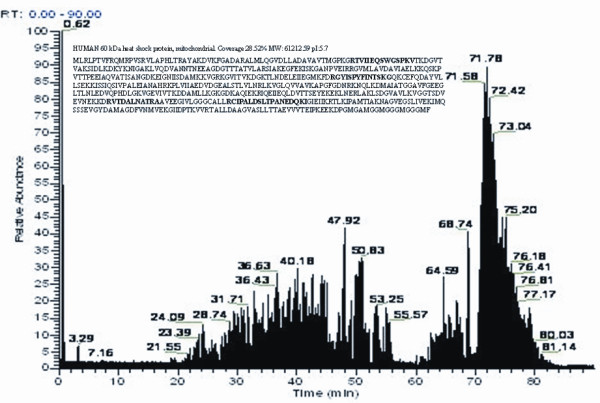
LC-MS spectrum obtained for spot 9. Peptide fragments were analyzed by LC-tandem MS and MALDI-TOF analysis of peak m/z was performed. Major monoisotopic peaks of trypsin-digested peptides, detected by MALDI-TOF MS, are indicated on the spectrum. The sequence of HSP60 protein was represented by single-letter code for amino acids on the top left corner of the image, where peptide matches between the sample and the HSP60 sequence are shown bold.